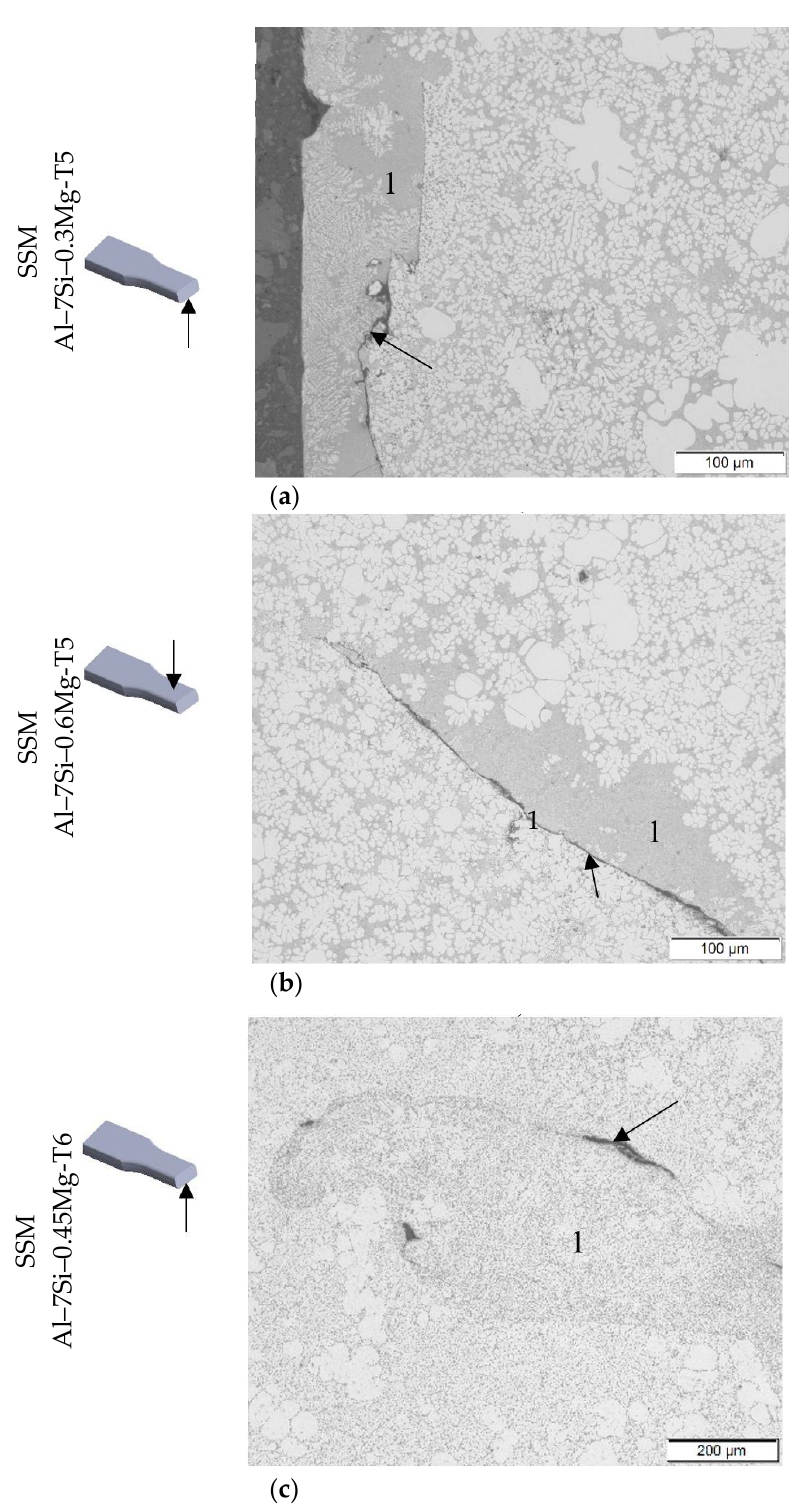
Figure 9. Optical micrographs showing regions of macrosegregation on the first 190 µm surface layer of ( a ) SSM Al–7Si–0.3Mg and ( b ) SSM Al–7Si–0.6Mg castings in the T5 condition and ( c ) SSM Al–7Si–0.45Mg casting in the T6 condition. 1—Region of positive macrosegregation. Arrows indicate the possible location of oxide films. The dashed line shows the die wall position during casting.